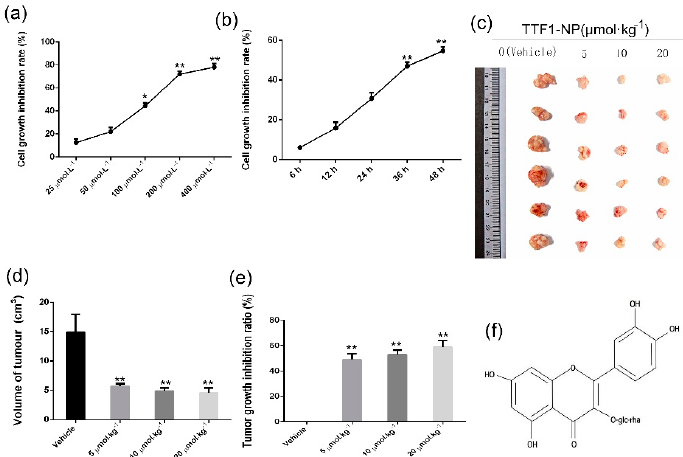
Figure 1. TTF1-NP inhibited human hepatoma HepG2 cells growth in vitro ( a , b ) and in vivo ( c , d , e ). ( a ) The cell growth inhibition ratio (%) for HepG2 cells were calculated after treatment with TTF1-NP in 25, 50, 100, 200, 400 μ M or DMEM medium (Vehicle) for 48 h, Cell growth inhibition ratio (%) = (OD Vehicle − OD treatment )/OD Vehicle × 100%; ( b ) The cell growth inhibition ratio (%) for HepG2 cells were calculated after treatment with TTF1-NP (100 μ M) for 6, 12, 24, 36 and 48 or 0 h (Vehicle), Cell growth inhibition ratio (%) = (OD Vehicle − OD treatment )/OD Vehicle × 100%; ( c ) Dynamic changes in gross tumor volume of tumors from HepG2 cells implanted into nude mice after treatment with TTF1-NP for 5, 10, and 20 μ mol ∙ kg − 1 , gross tumor volume = 1/2 (length × width 2 ); ( d ) Volumes of tumors (cm 3 ) were calculated after treatment with TTF1-NP for 5, 10, and 20 μ mol ∙ kg − 1 ; ( e ) Tumor growth inhibition ratio (%) were calculated after treatment with TTF1-NP for 5, 10, and 20 μ mol ∙ kg − 1 , tumor growth inhibition ratio (%) = (TW Vehicle − TW treatment )/TW Vehicle × 100%; ( f ) Chemical structure of TTF1-NP. Results are presented as mean ± SD from five or six independent tests with triplicate samples. * p < 0.05, ** p < 0.01 for the designated treatment vs. Vehicle.